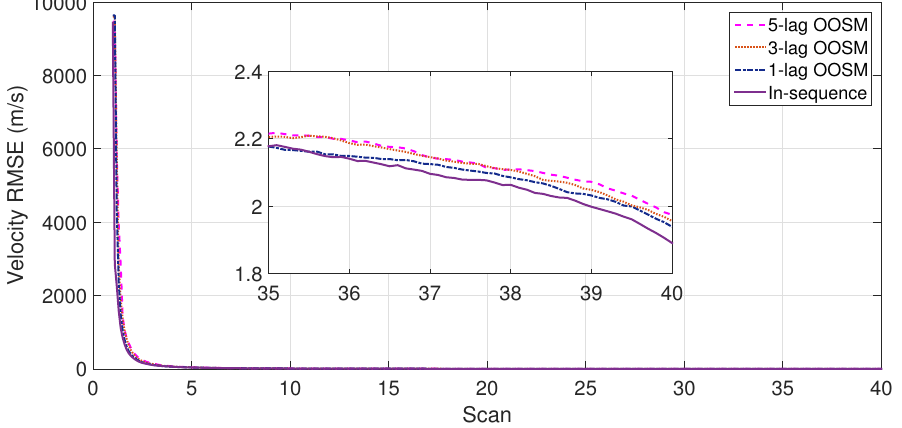
Figure 6. RMSE in velocity estimate for the A l 1 algorithm.